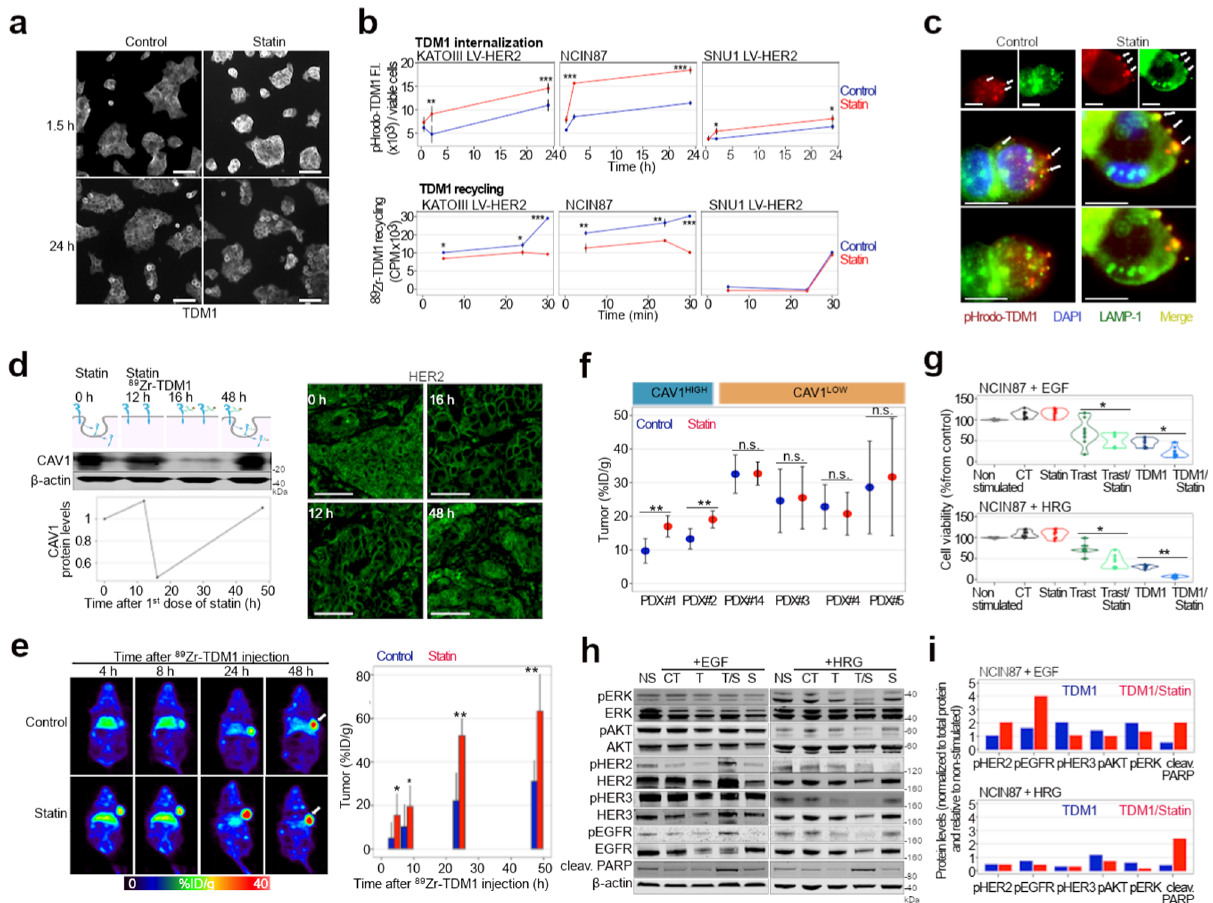
Fig. 3 Statins enhance TDM1 binding and internalization. a Confocal images of immuno fl uorescence of TDM1 in the presence or absence of lovastatin. Scale bars: 20 μ m. b TDM1 internalization and recycling in NCIN87 GC cells wild-type (WT) and AGS, KATOIII, SNU1 GC sublines stably expressing HER2 (LV-HER2) in the presence and absence of lovastatin. The pHrodo-TDM1 fl uorescent signal was normalized to the number of viable cells (* P < 0.05 , **P < 0.01, ***P < 0.001 based on a Student ’ s t test, n = 4). c Confocal images of immuno fl uorescence staining of pHrodo-TDM1 and LAMP1 in NCIN87 cells in the presence and absence of lovastatin. Scale bars: 100 μ m and 50 μ m (inset). d Western blot of CAV1 and HER2 immuno fl uorescence in NCIN87 s.c. tumors from athymic nude mice. Lovastatin (8.3 mg/kg of mice) was orally administrated twice with an interval of 12 h between each administration. Scale bars: 50 μ m. e Representative coronal PET images and TDM1-tumor uptake at 4, 8, 24, and 48 h p.i. of [ 89 Zr]Zr-DFO-TDM1 in athymic nude mice bearing s.c. NCIN87 tumors. Lovastatin (8.3 mg/kg of mice) was orally administrated 12 h prior and at the same time as the tail vein injection of [ 89 Zr]Zr-DFO- TDM1 (6.66 – 7.4 Mbq, 45 – 50 μ g protein). Bars, n = 5 mice per group, mean ± S.E.M. * P < 0.05 , **P < 0.01, ***P < 0.001 based on a Student ’ s t test. %ID/g, percentage of injected dose per gram. f [ 89 Zr]Zr-DFO-TDM1 uptake in HER2-expressing gastric PDXs containing varying levels of CAV1 and administered saline (blue color) or statin (red color). PDX IDs in this fi gure match patient IDs shown in Fig. 1. Points, n = 5 mice per group, mean ± S.E.M, **P < 0.01 based on a Student ’ s t test. %ID/g, percentage of injected dose per gram. g Cell viability of NCIN87 cells at 48 h after cells incubation with Trastuzumab (Trast) and TDM1 alone or in combination with lovastatin. Bars, n = 5 – 7 per group, mean ± S.E.M. * P < 0.05 , **P < 0.01 , based on a Student ’ s t test. h , i Western blots of HER2 signaling and quanti fi cation of NCIN87 cells after 48 h incuba t ion with TDM1 alone or in combination with lovastatin. Bars, Source Data fi